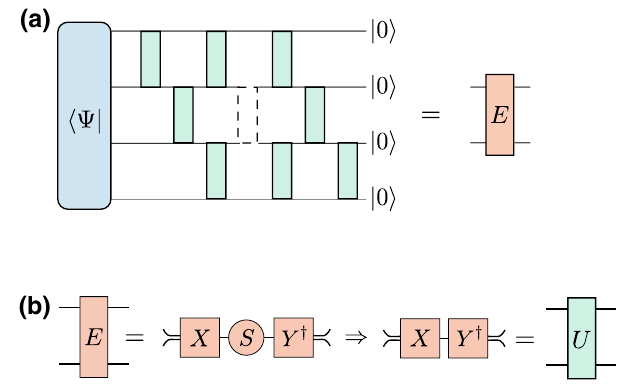
FIG. 10. (a) The environment tensor is constructed by exclud- ing the pertinent unitary from the overall contraction and viewing the resulting tensor network as a four-index tensor. (b) To update U i , j , we perform a polar decomposition of the environment tensor.